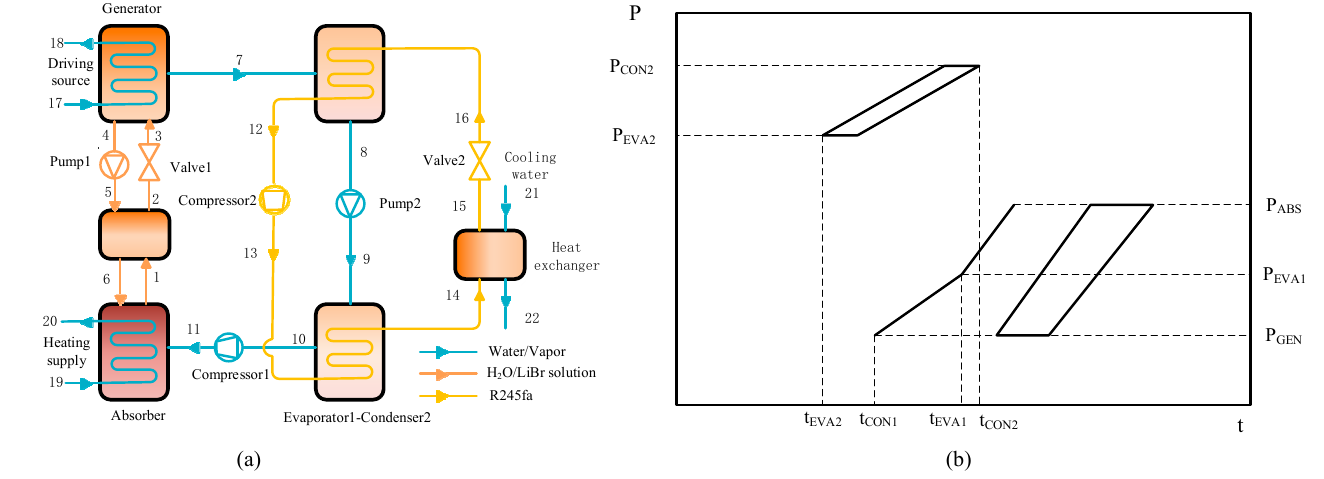
Figure 2. Working processes of the hybrid cycle ( a ) and the whole cycle in P-t diagram ( b ). The weak solution (3) enters the generator, which produces vapor (7) and strong solution (4); the strong solution (6) absorbs the superheated vapor (11) in the absorber. Then, vapor (7) enters the hybrid condenser-evaporator for release of heat and becomes saturated water (8), which is later pressurized by the pump (2) and enters the evaporator-condenser to become saturated vapor (10) finally. The vapor (10) superheated by compressor (1).